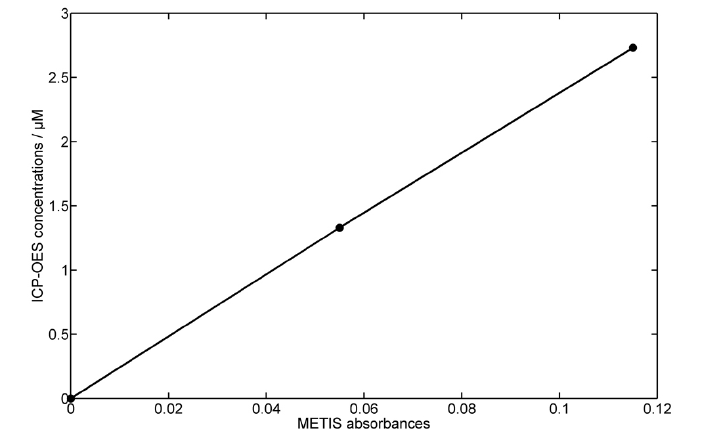
Figure 8. METIS absorbances as a function of dissolved Mn concentrations measured by ICP-OES. Minimum (0.077 µ M) and maxima (1.3 µ M, 2.7 µ M) of ICP-OES measurements were correlated to corresponding METIS absorbances (R 2 =